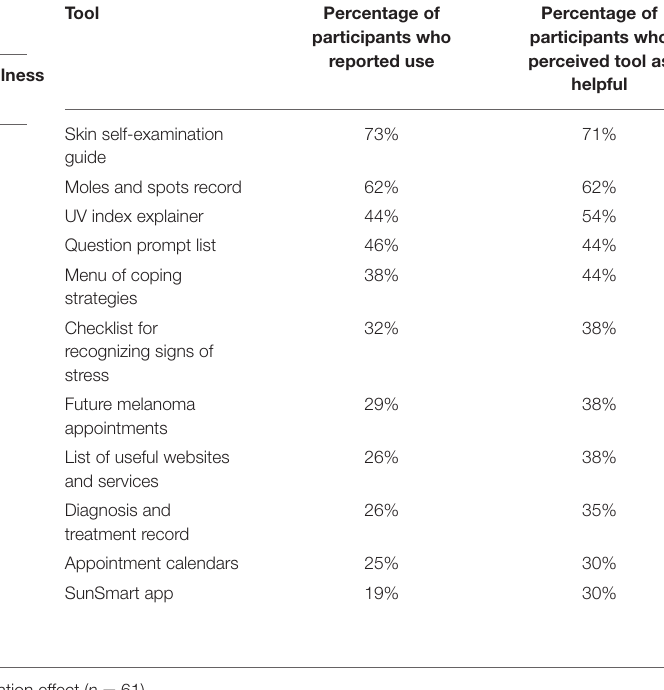
TABLE 6 | Multiple linear regression examining potential moderators of intervention effect ( n =